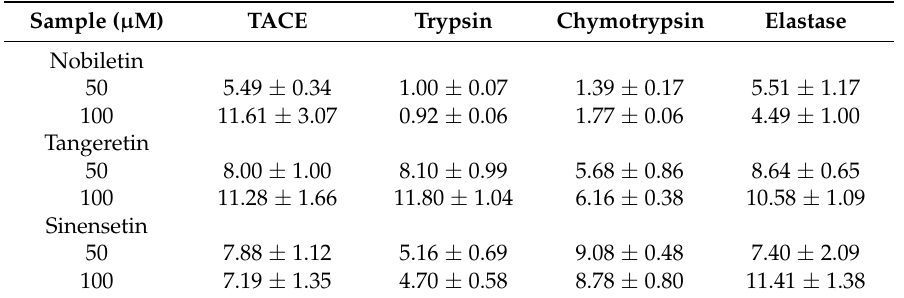
Figure 2. β -Secretase (BACE1) inhibitory activities of polymethoxyflavones (PMFs). The activities (%) are expressed as mean ± standard deviation (SD) of three independent experiments. Each concentration of the same compounds is significantly different at *** p < 0.001. The same concentrations of each compound with different letters are significantly different at p < 0.001. Table 1. Inhibitory activities (%) of polymethoxyflavones (PMFs) 1,2 against α -secretase (tumor necrosis factor- α converting enzyme, TACE) and other serine